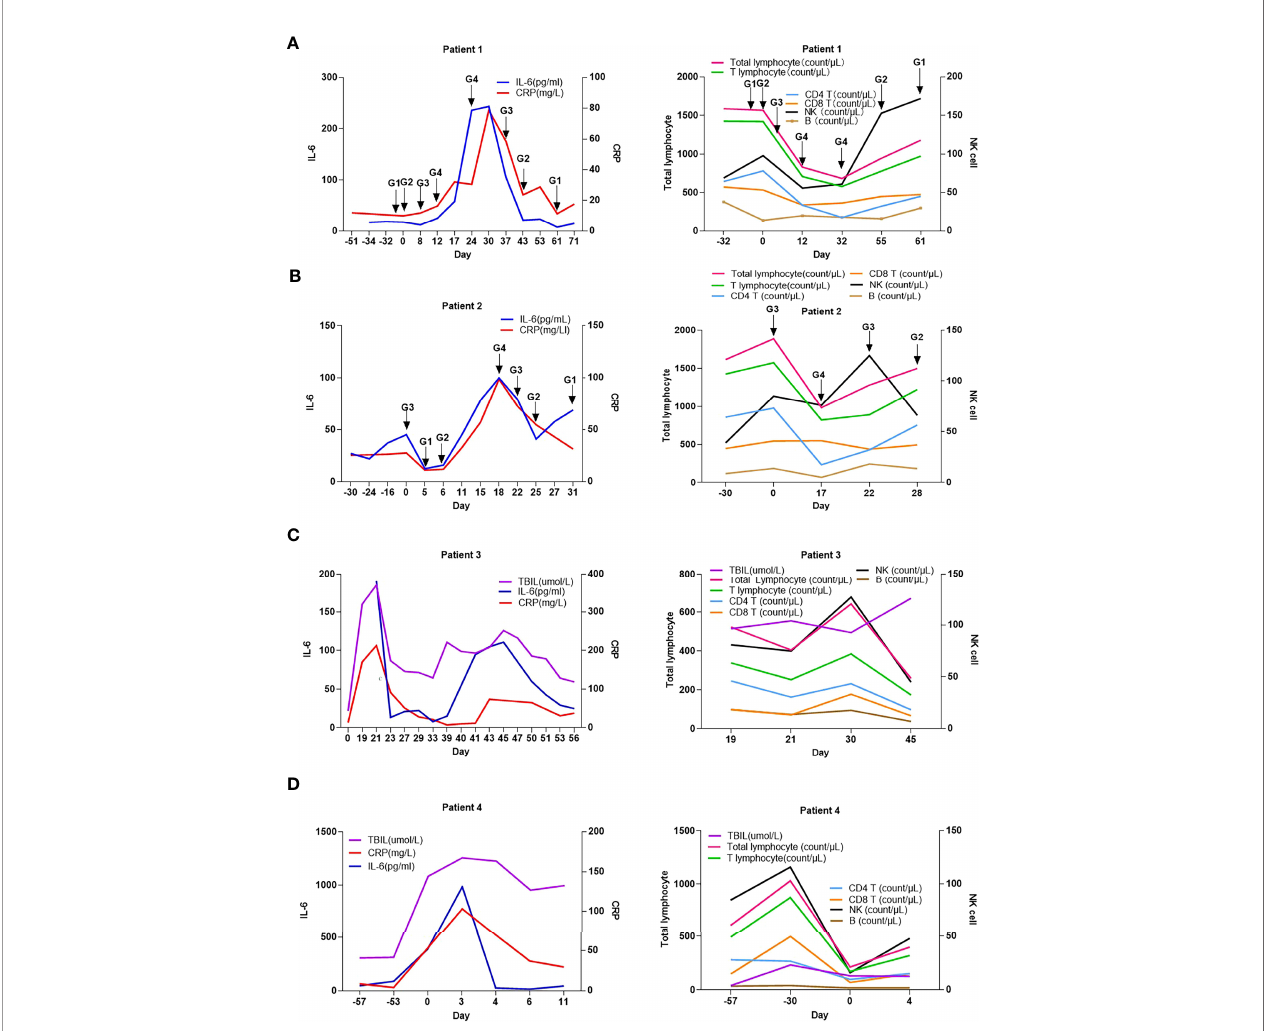
FIGURE 2 | Changes in c-reactive protein level, interleukin-6 level, and lymphocyte subsets with the development of immune-related adverse events in 4 patients overtime. (A) patient 1; (B) patient 2; (C) patient 3; (D) patient 4; CRP, C-reactive protein; IL-6, interleukin-6; G1: grade 1; G2, grade 2; G3, grade 3; G4, grade 4; 0 Day, day of